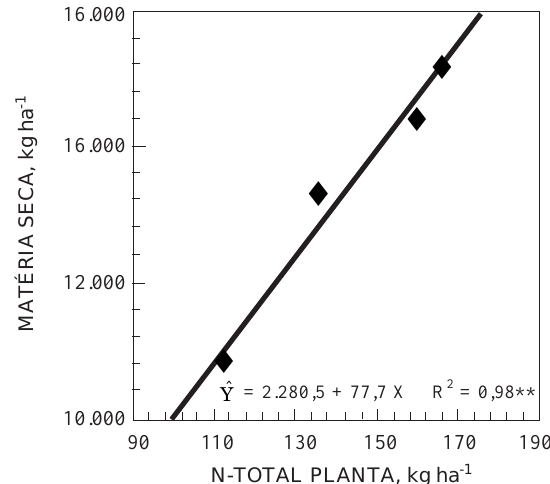
Figura 4. Efeito da absorção de N-total na produção de matéria seca na cultura do milho em sistema plantio